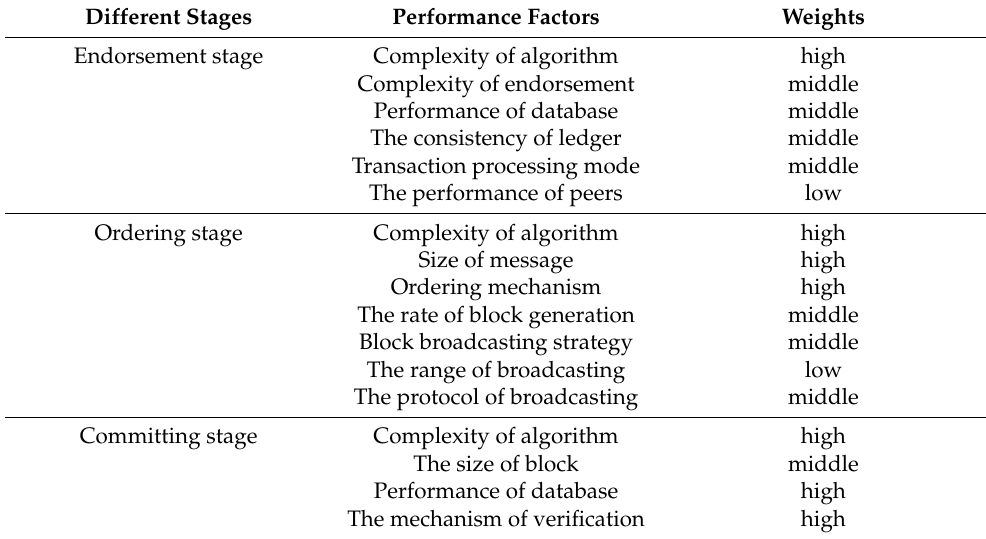
Table 1. The weights of key performance factors in